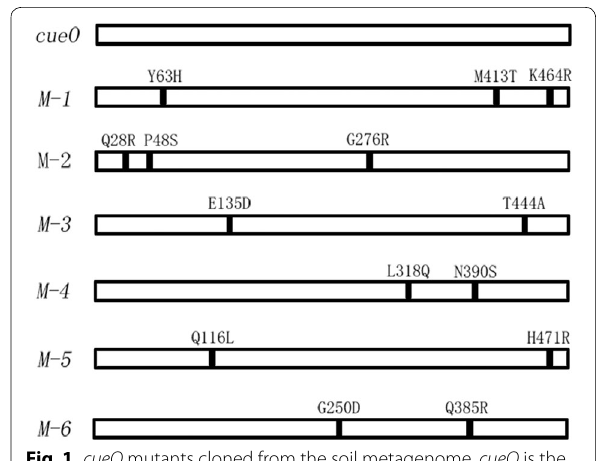
Fig. 1 cueO mutants cloned from the soil metagenome. cueO is the wild-type gene. M - 1 , M - 2 , M - 3 , M - 4 , M - 5 , and M - 6 represent the differ- ent mutants. These genes were amplified by the primers cueO -F and cueO -R, and gene mutants are shown by vertical bars